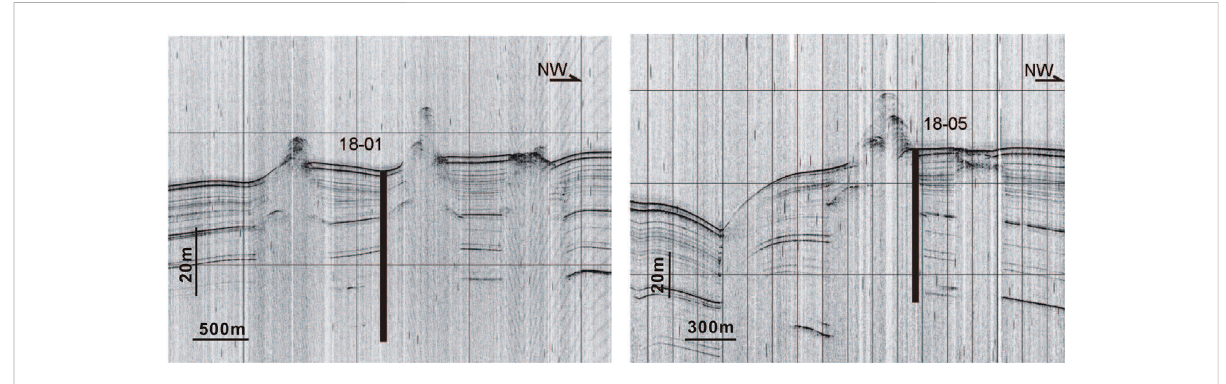
FIGURE 2 Sub-bottom pro fi les across two drilling